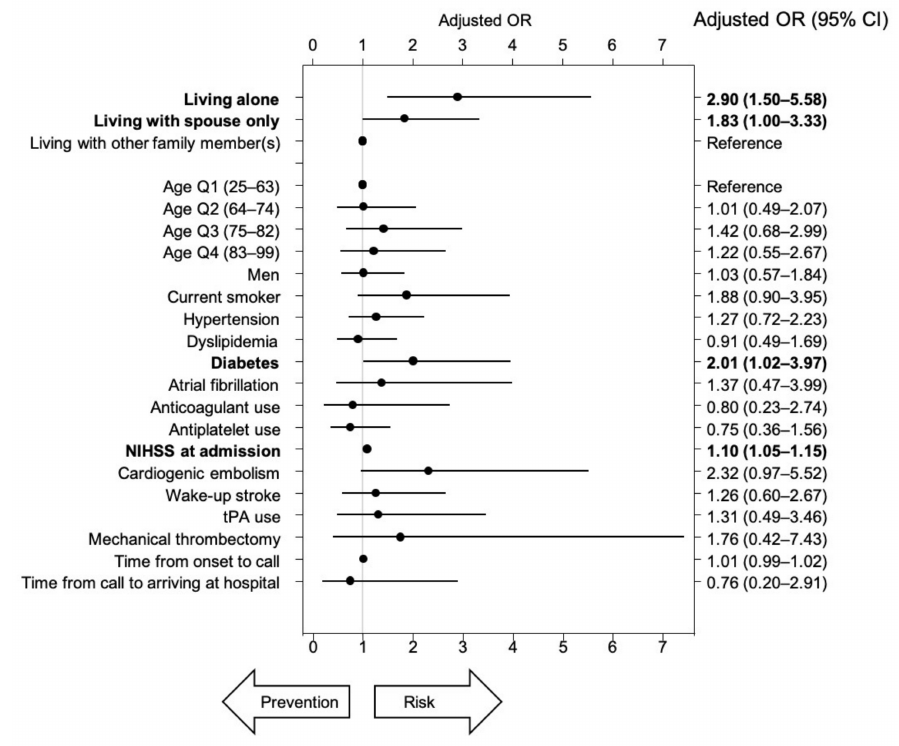
Figure 5. Adjusted odds ratios for worsening by at least one grade on the mRS after the stroke onset. tPA: tissue plasminogen activator. Bold type shows significant di ff erences in the 95% CI.